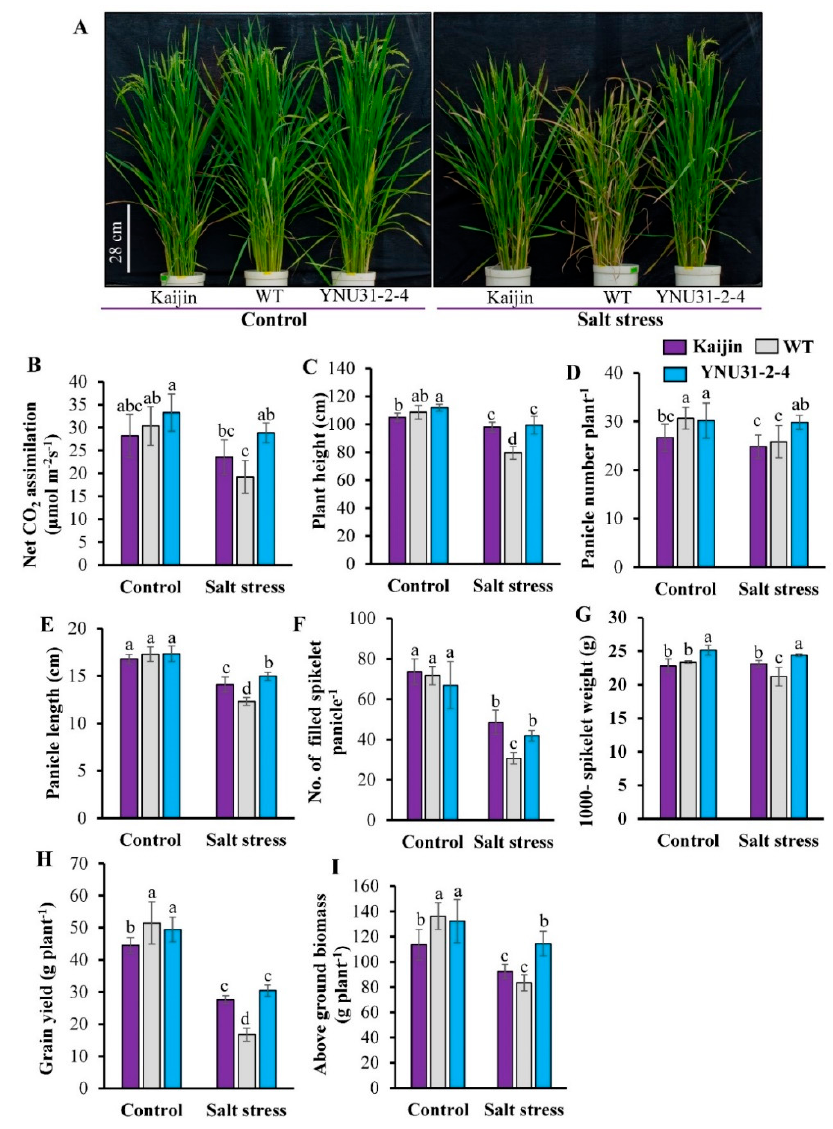
Figure 7. Salinity tolerance of BC 3 F 3 line “YNU31-2-4” at heading. ( A ) Phenotypic comparison of “Kaijin”, WT, and “YNU31-2-4” plants grown with or without salt stress. Salt-stressed plants were grown in 50 mM NaCl from 60 days after germination (DAG) and then in 75 mM from 74 DAG until 95 DAG (booting stage), and then in fresh water until 110 DAG (heading). ( B ) Net CO 2 assimilation rate of the penultimate leaf four weeks after imposition of salt treatment. ( C ) Comparison of plant height at 110 DAG. ( D–I ) Comparisons of ( D ) number of panicles / plant, ( E ) panicle length, ( F ) number of filled spikelets / panicle, ( G ) weight of 1000 filled spikelets, ( H ) grain yield / plant, and ( I ) dry weight of aboveground biomass at harvest. Data are mean ± SD of 6 individuals. Bars with the same letter are not statistically di ff erent (Duncan’s multiple range test, p <